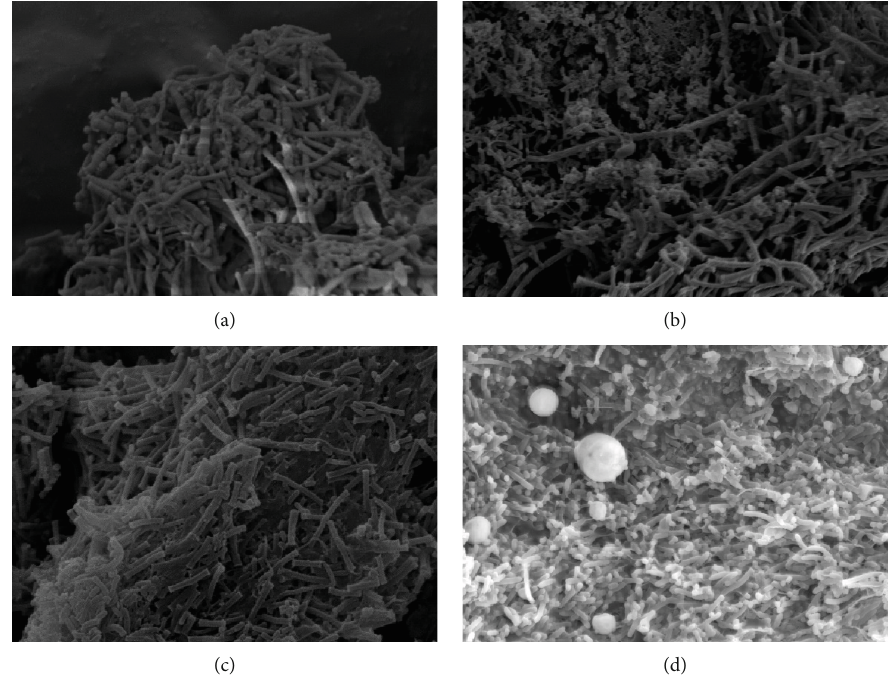
Figure 4: AnAS morphology in Stage II ((a) compartment 1, 5 k; (b) compartment 2, 5k; (c) compartment 3, 5 k; (d) compartment 4, 5